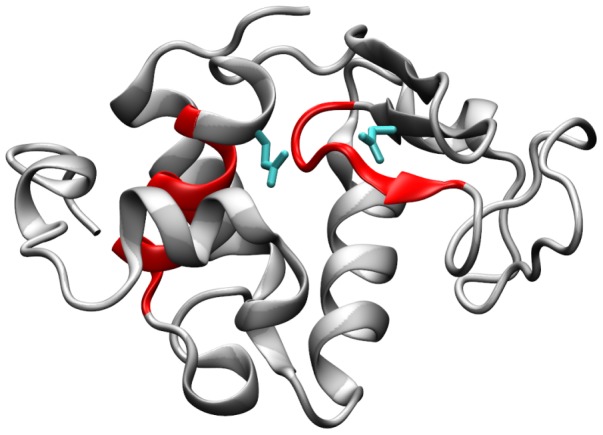
Catalytic residues that make structural contact (distance cut-off 4.5 Å) with Amylsegs of human lysozyme are shown.The human lysozyme (UniProtKB entry: P61626) contains two catalytic residues, Glu 35 and Asp 53. These residues are represented as cyan colored sticks and are in contact with Amylsegs (25-LANWMCLAKW-34 and 56-IFQINS-61) represented by red colored ribbons. The image was made using the PDB entry, 1IWT.